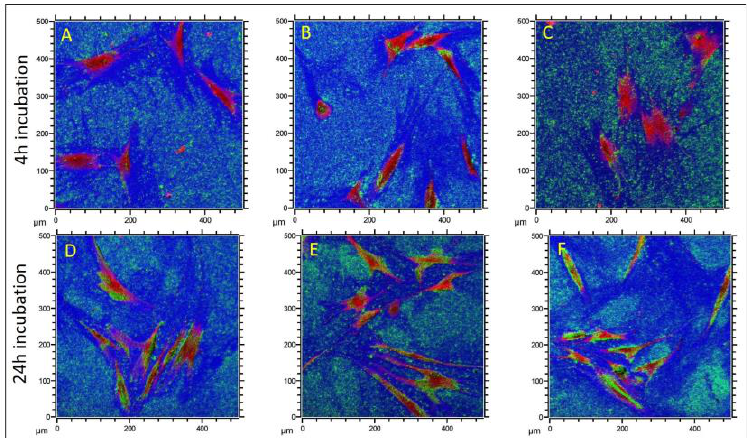
Figure 4. Post erosion, high lateral resolution ToF-SIMS images derived from three positions showing cells incubated with TZ-0 particles for 4 h ( A – C ) and 24 h ( D – F ). Sum of Na + , K + , Ca + and CaF + signals (showing the footprints of the cells) in the red channel. Sum of zirconium isotopes and ZrO + isotopes in green channel, and the underlying Si in the blue channel. Table 2. Summarized results of the SIMS analysis of cell cultures incubated with differently-sized ZrNP for 4 h and 24 h. n = 2 (independent experiments with duplicates).